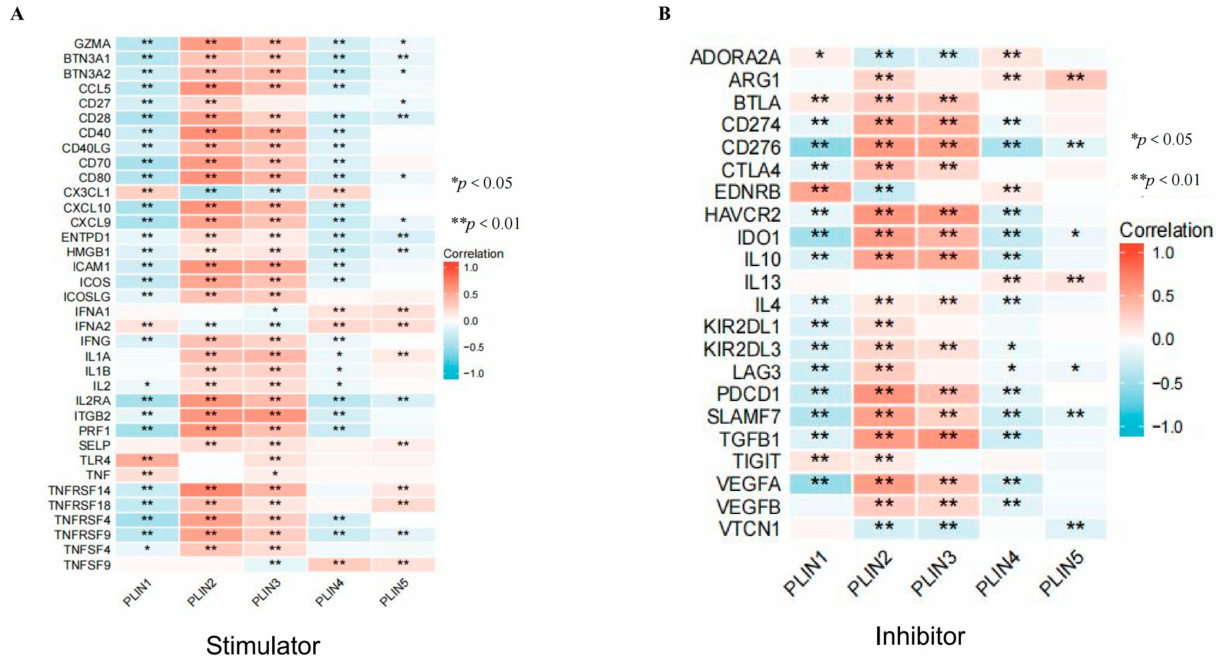
Figure 8. Correlation of PLINs with immune checkpoint genes in gliomas. ( A ) Immunostimulatory factors. ( B ) Immunosuppressive factors. (* p < 0.05; ** p <